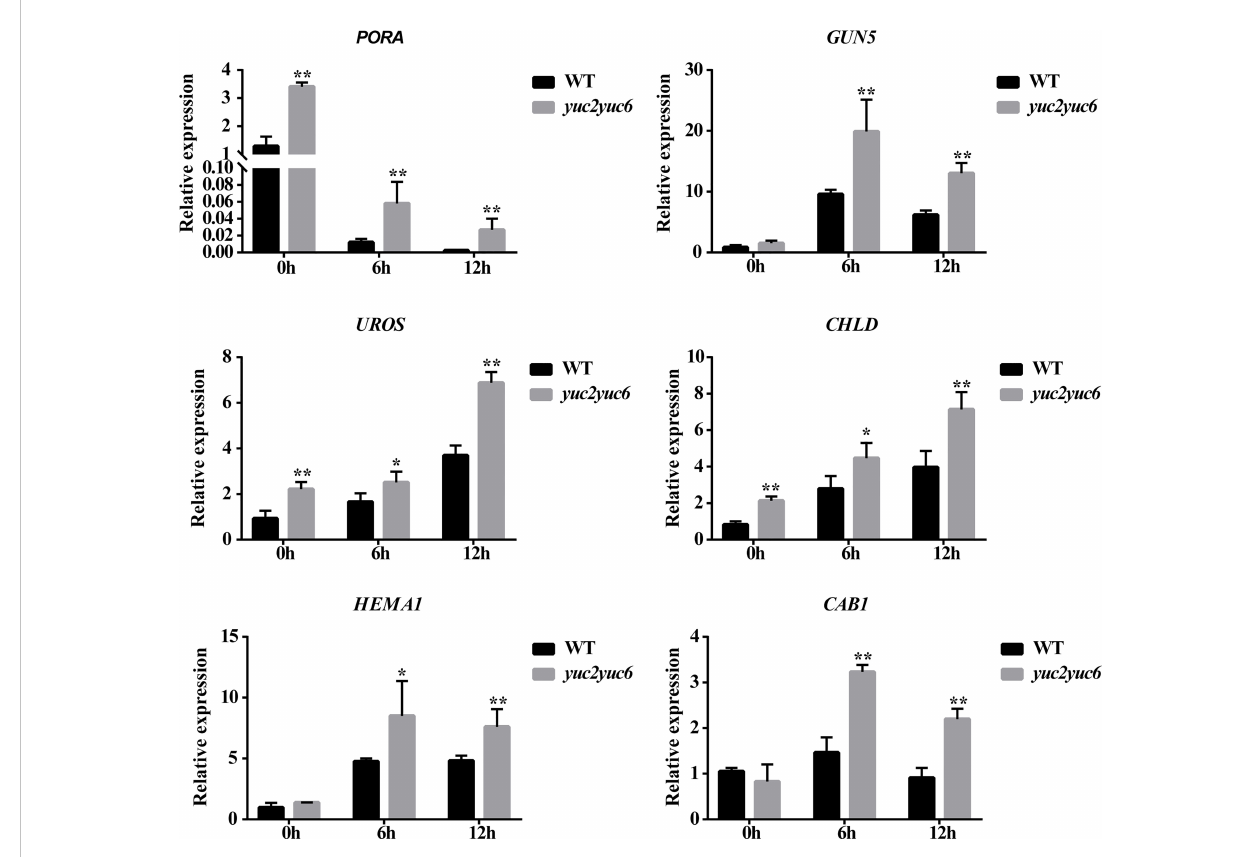
FIGURE 6 Chlorophyll gene expression of seedlings during de-etiolation. * represents p value <0.05, ** represents p value